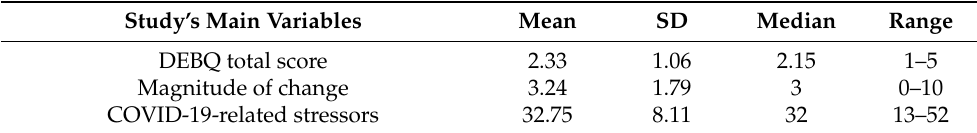
Table 3. Description of the study’s main